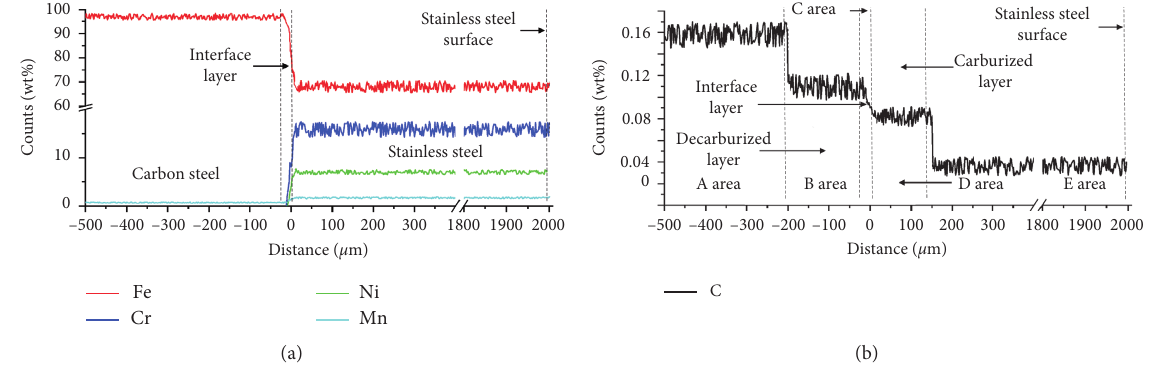
Figure 7: The element distribution in the thickness direction of the bimetal plate: (a) the element content of Fe, Cr, Ni, and Mn and (b) the element content of C.